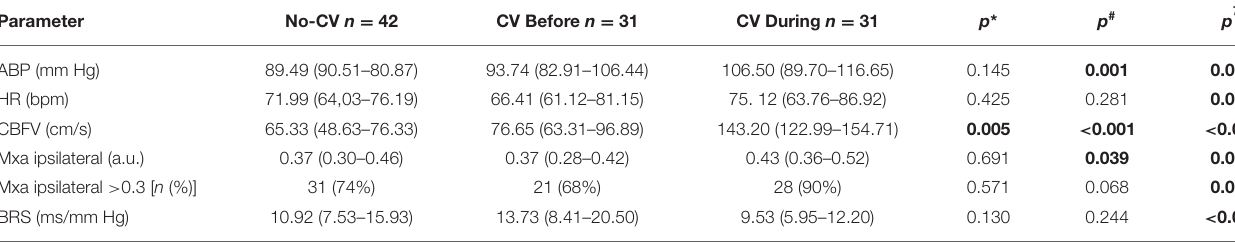
TABLE 2 | Physiological metrics and cerebral autoregulation in patients with and without cerebral vasospasm (CV). Parameter